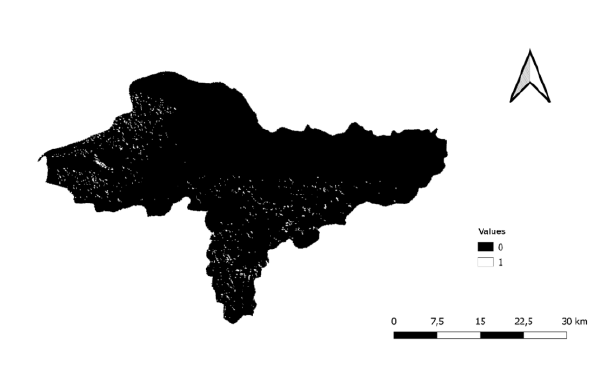
Figure 9 . Suitable installation sites